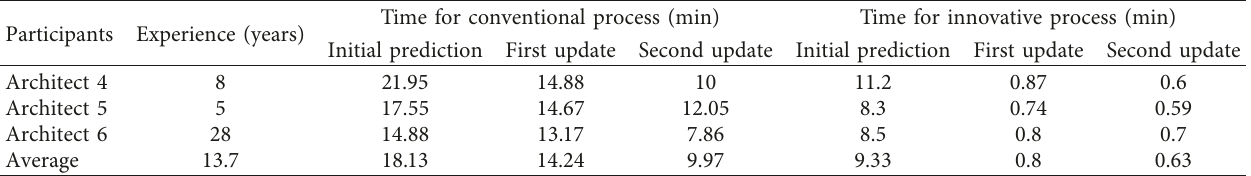
Table 5: Time spent on case